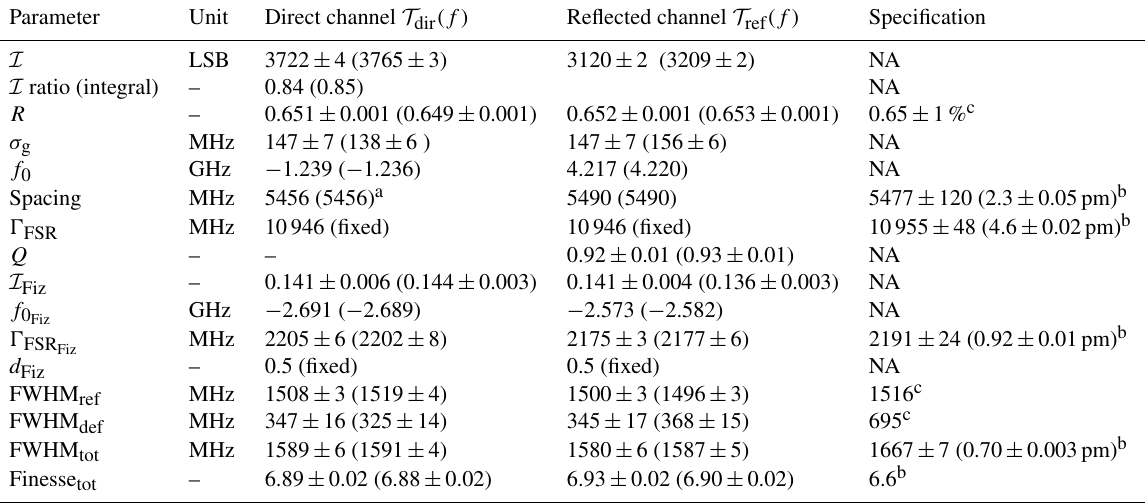
Table 3. Fit parameters according to Eqs. (9), (11), and (12) for energy-corrected ISR data by means of E norm in the fit values denotes the standard error derived by the fit routine.